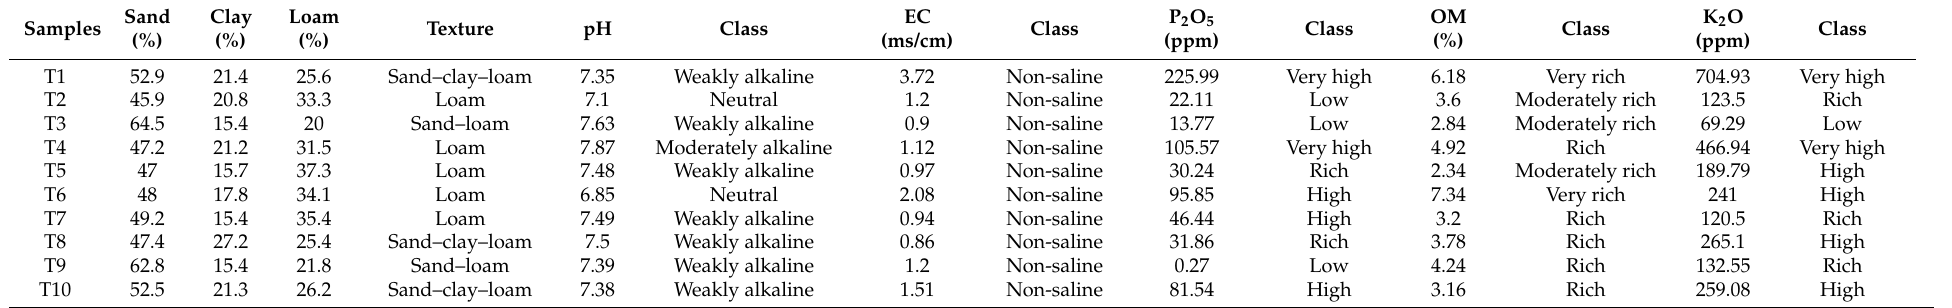
Table 1. Physicochemical results of the soil samples.